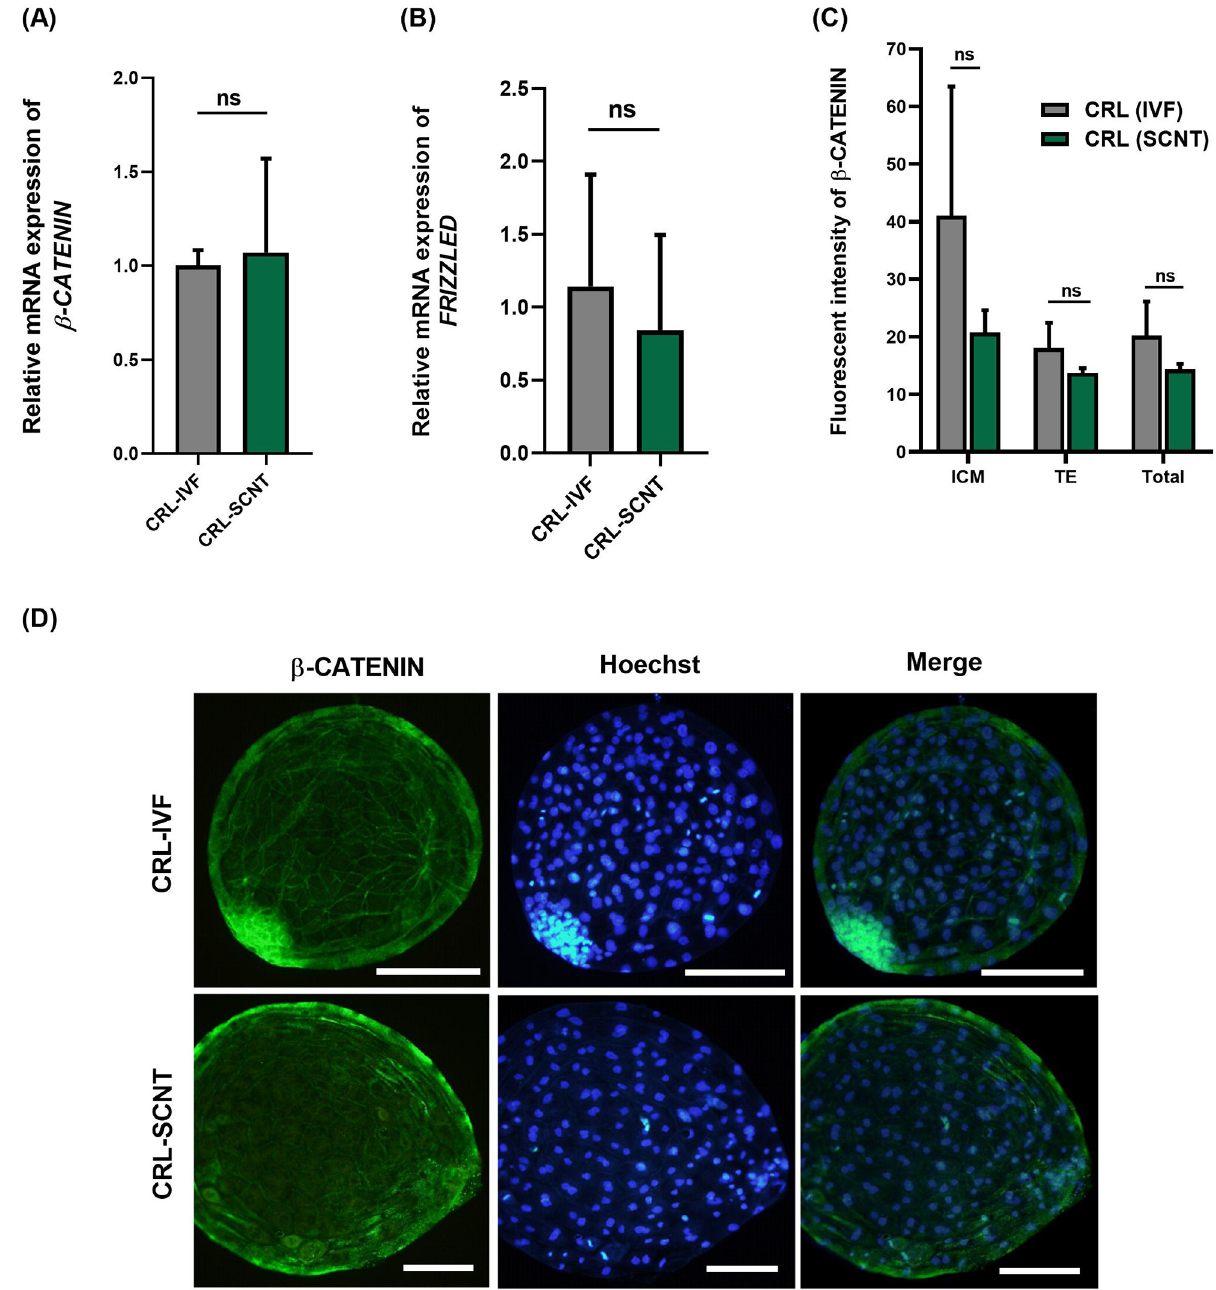
Fig 3. (A) Relative mRNA expression of (A) β -CATENIN and (B) FRIZZLED in IVF and SCNT blastocysts in goat. (C) Quantification of fluorescent intensity of β -CATENIN level in IVF and SCNT blastocysts. (D) Representative immunofluorescence images of β -CATENIN in IVF and SCNT blastocysts. Mean ± S.E.M. values are from at least three independent experiments (ns: P > 0.05). Scale bars represent 200 μ